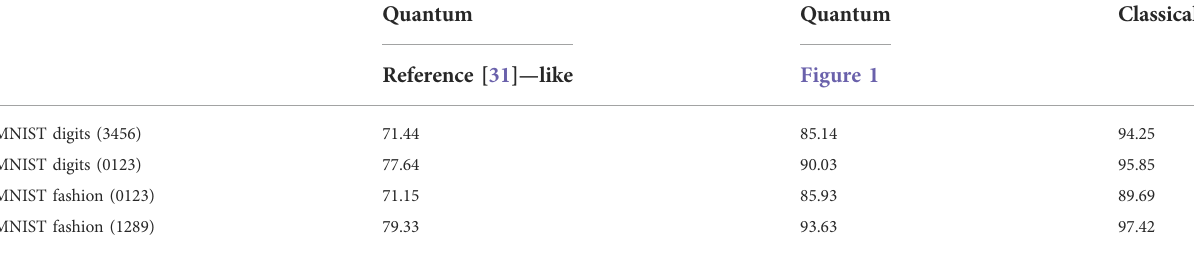
TABLE 2 Accuracies of classi fi cation for quantum and classical convolutional neural networks.